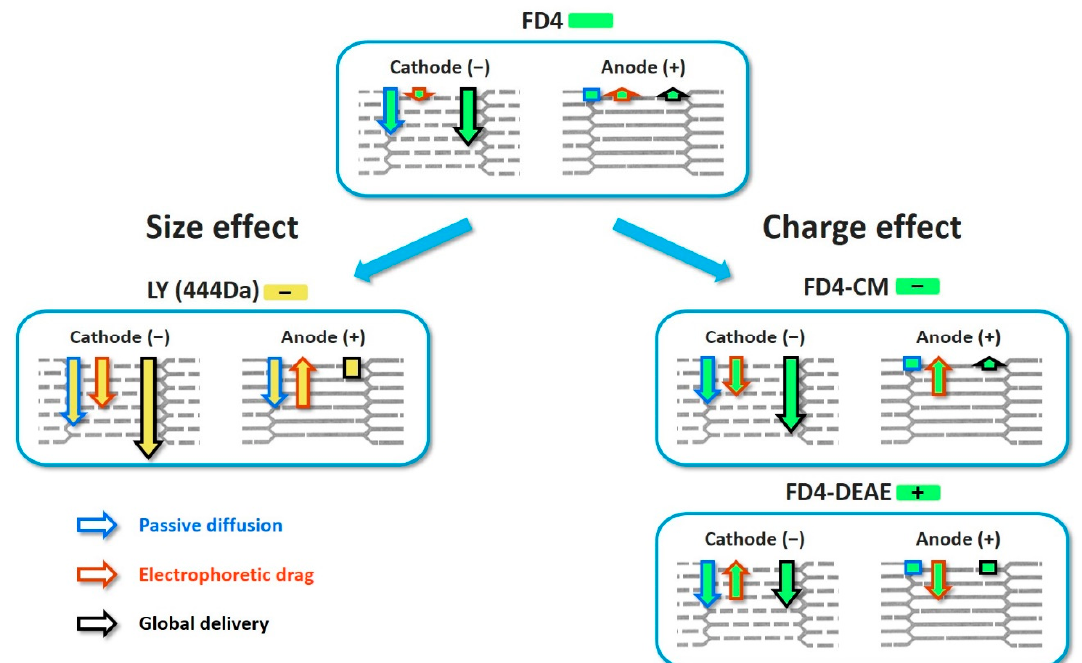
Figure 8. Scheme of the global delivery resulting from passive diffusion through aqueous pathways generated upon EP treatment and electrophoresis, depending on molecule size and charge. FD4 global charge was considered negligible compared to other presented molecules and results in a reduced electrophoresis contribution. At the cathode, LTRs were sufficient for FD4 to accumulate in the SC. Passive diffusion and electrophoresis combined for an improved delivery. At the anode, LTRs were not sufficient to allow passive diffusion, and the remaining electrophoresis opposed global delivery and reduced the uptake. LY is smaller than FD4 and the generated LTRs are sufficient for its passive diffusion at both electrodes. At the cathode, both forces combined to greatly improve the delivery while they nullified each other at the anode. For FD4-CM, the electrophoresis had a higher contribution, so the uptake was higher at the cathode, while unchanged at the anode, compared to FD4. Finally, FD4-DEAE charge was the opposite of the three other molecules. As such, the electrophoresis contribution on each side was reversed. It opposed passive diffusion at the cathode resulting in a decreased delivery compared to FD4. The delivery at the anode was however unaffected by the electrophoretic drag, since LTRs were not sufficient to allow passage to the macromolecule.